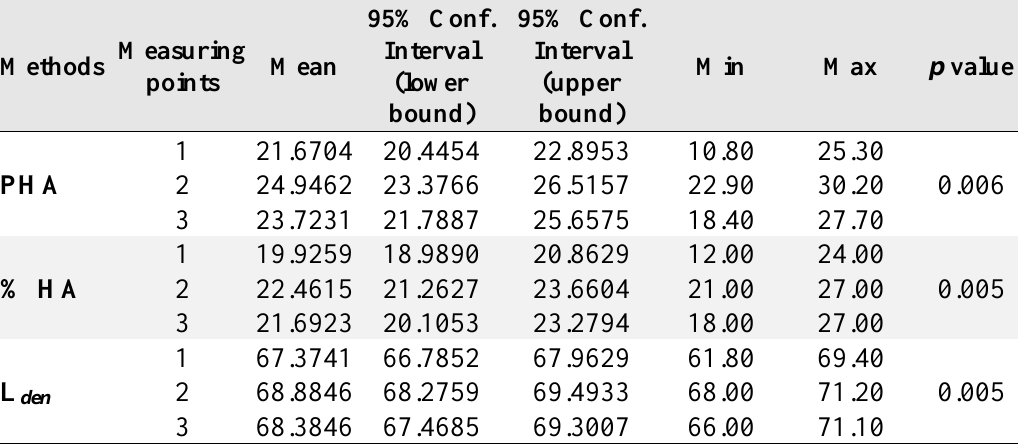
Table 6. Comparing the two methods (% HA vs. PHA) – all measurements from three measuring points shown